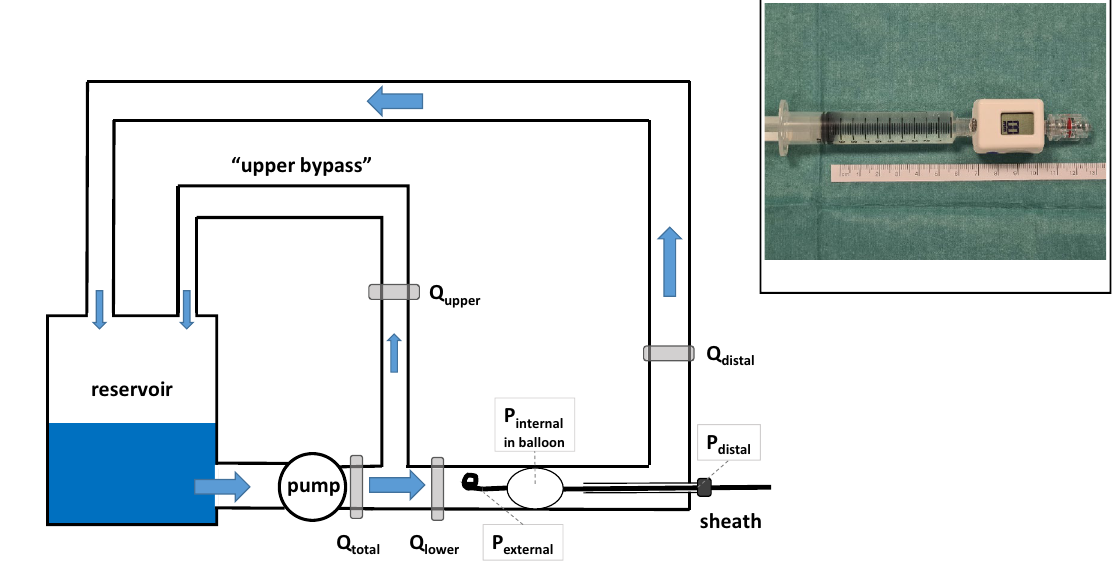
Figure 1. Schematic drawing of the model. Q denotes flow measured on the flow probes (“total” flow in the system, “upper” flow in the bypass resembling the upper body, “lower” in the part resembling the lower body, and “distal” the flow distal to the balloon), and P denotes pressure (“external” the blood pressure at the tip of the REBOA catheter, “internal” the pressure in the balloon of the REBOA catheter, and “distal” the blood pressure at the side port of the sheath). The diameter of the “descending aorta” is 21 mm. The inset shows a photograph of the COMPASS device with a 10 ml syringe attached. The device has two Luer connectors (male/female) for in-line connection in a pressure line and measures about 1.5 × 2 × 3